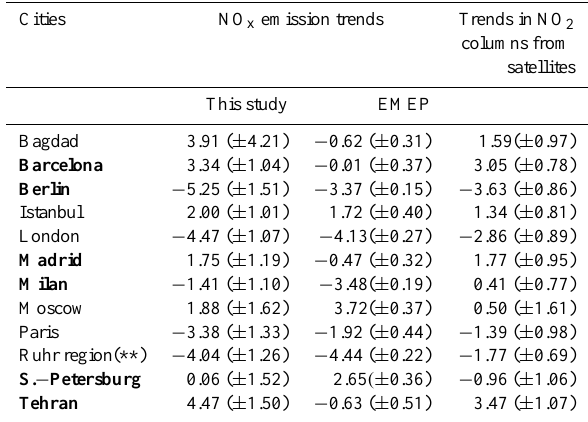
Table 2. Estimates (*) of the trends in NO x emission and NO 2 columns for several urban agglomerations (in percent per